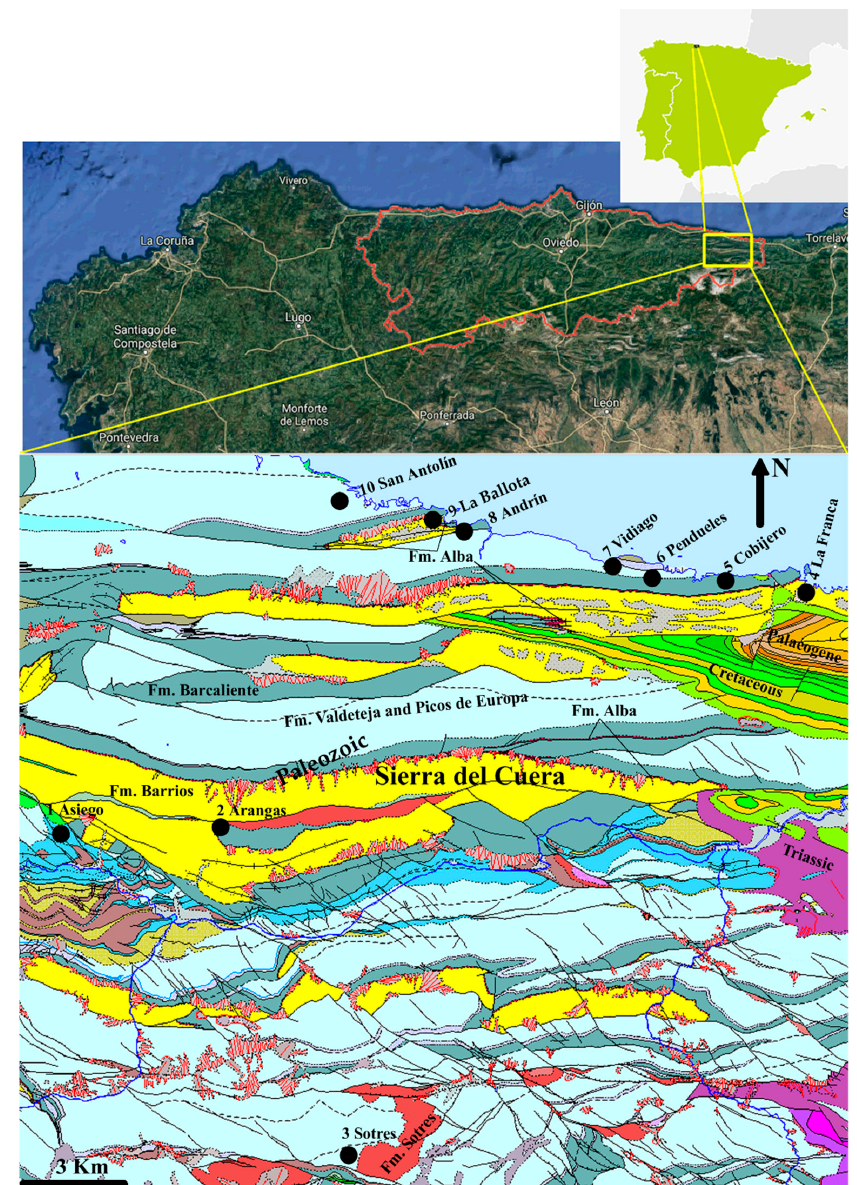
Figure 1. Geological context of studied zone and locations of the 10 chert outcrops. ©Instituto Geológico y Minero de España (IGME) (2020) https://igme.maps.arcgis.com/home/webmap/viewer.html?webmap=44df600f5c6241b59edb596f54388ae4 (accessed on 10 March 2021) [9]. The formations represented in the map of Figure 1 correspond to the Paleozoic base- ment of the Cantabrian Zone and are: (a) The Vegami á n Formation (Tournaisian) [10], with a lithological composition charac- terized by a quartzite band with satiny black shales with layers of black lydites about 10 cm thick. (b) The Barcaliente Formation (Sepurjovian) [11] is characterized by a black colour and fine-grained waxy lustre limestone with a fetid odour and a characteristic continuous millimetric banding marked by differences in colouring. (c) The Valdeteja Formation (Bashkirian-Middle Muscovian) [11] is characterized by a coarse-grained grey limestone with high fossiliferous